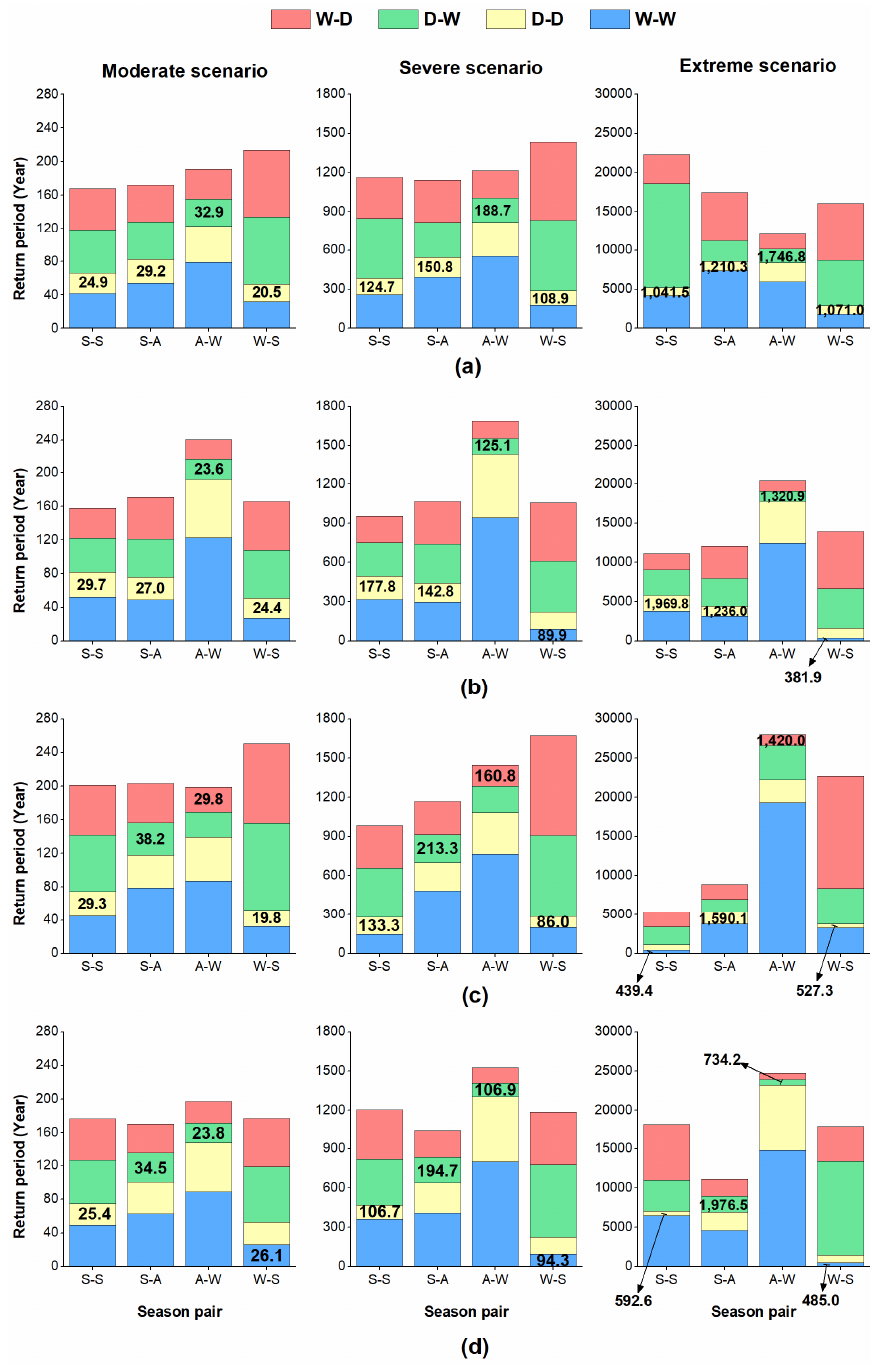
Figure 4. Joint return periods of dryness–wetness combinations between adjacent seasons under three severity scenarios at ( a ) the upper reach, ( b ) the Yishusi River basin, ( c ) the middle reach and ( d ) the lower reach of the HRB. D–D (W–W) represents a continuously dry (wet) condition between adjacent seasons. D–W (W–D) denotes an abrupt transition from dryness (wetness) to